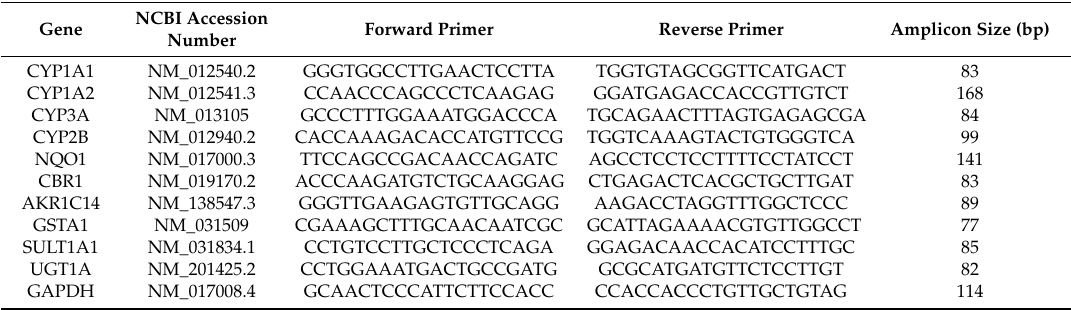
Table 1. Target and reference genes selected for qPCR. National Center for Biotechnology Information (NCBI) reference sequences, primers, and amplicon